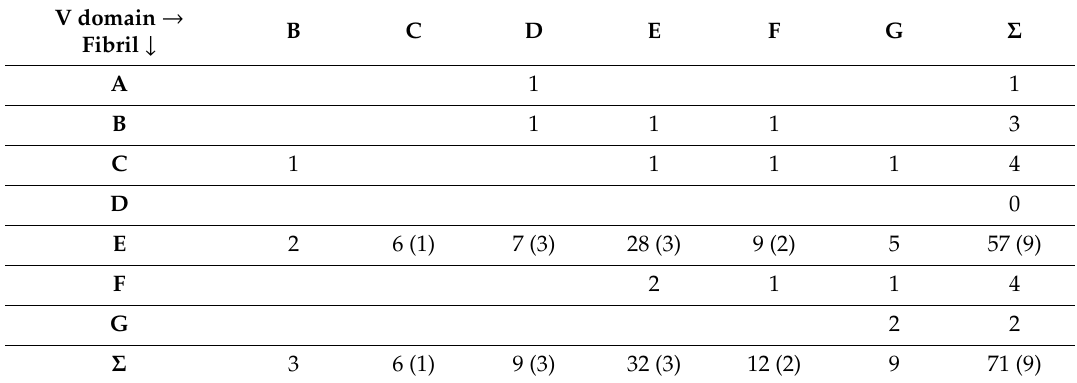
Table 5. Changes in the location of structural codes. Rows—structural codes of the native form of the V domain, columns—structural codes present in the amyloid form. Numbers in brackets—number of residues of high intrinsic hydrophobicity di ff erence in comparison with those present in amyloid form. A-G – zones on Ramachandran map distinguished according to local maxima on the ellipse path.